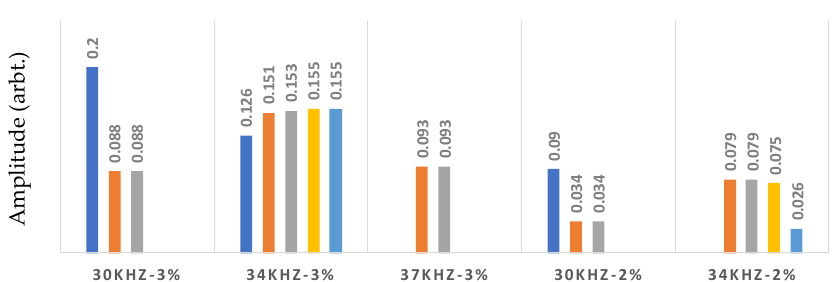
Figure 16. Bar graphs of the detection length of the defect using the average value of all of the methods in the first set of tests.